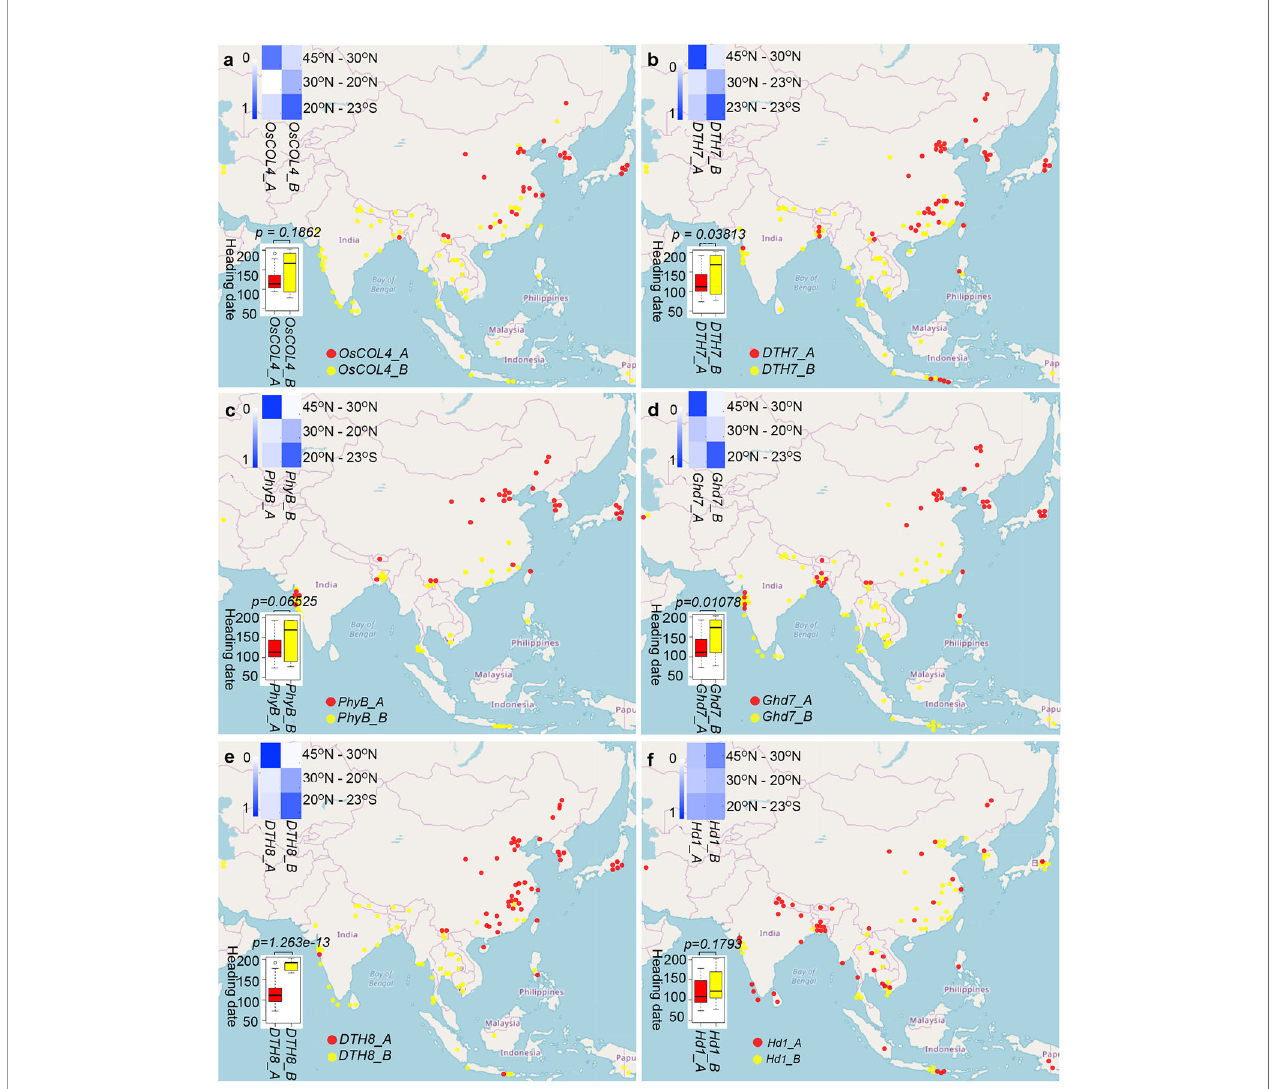
FIGURE 2 | Relationships among haplotypes of six long-day suppressor genes and their heading dates and geographical distribution patterns in cultivated rice. (A) OsCOL4 (B) DTH7 (C) PhyB (D) Ghd7 (E) DTH8 (F) Hd1. The boxplots illustrate the correlation between heading date on the y -axis and haplotype group (A or B) on the x -axis for each of the six genes. Red represents group A haplotypes, and yellow represents group B haplotypes. The blue heatmaps show the frequency of occurrence of each haplotype group at different latitudes. Each cell of the heatmap reports haplotype frequency, and haplotype frequency is accompanied by blue color, with higher haplotype frequency associated with darker blue colorings. The map shows the geographic distribution of haplotype groups for each gene, with red dots representing group A haplotypes and yellow dots representing group B